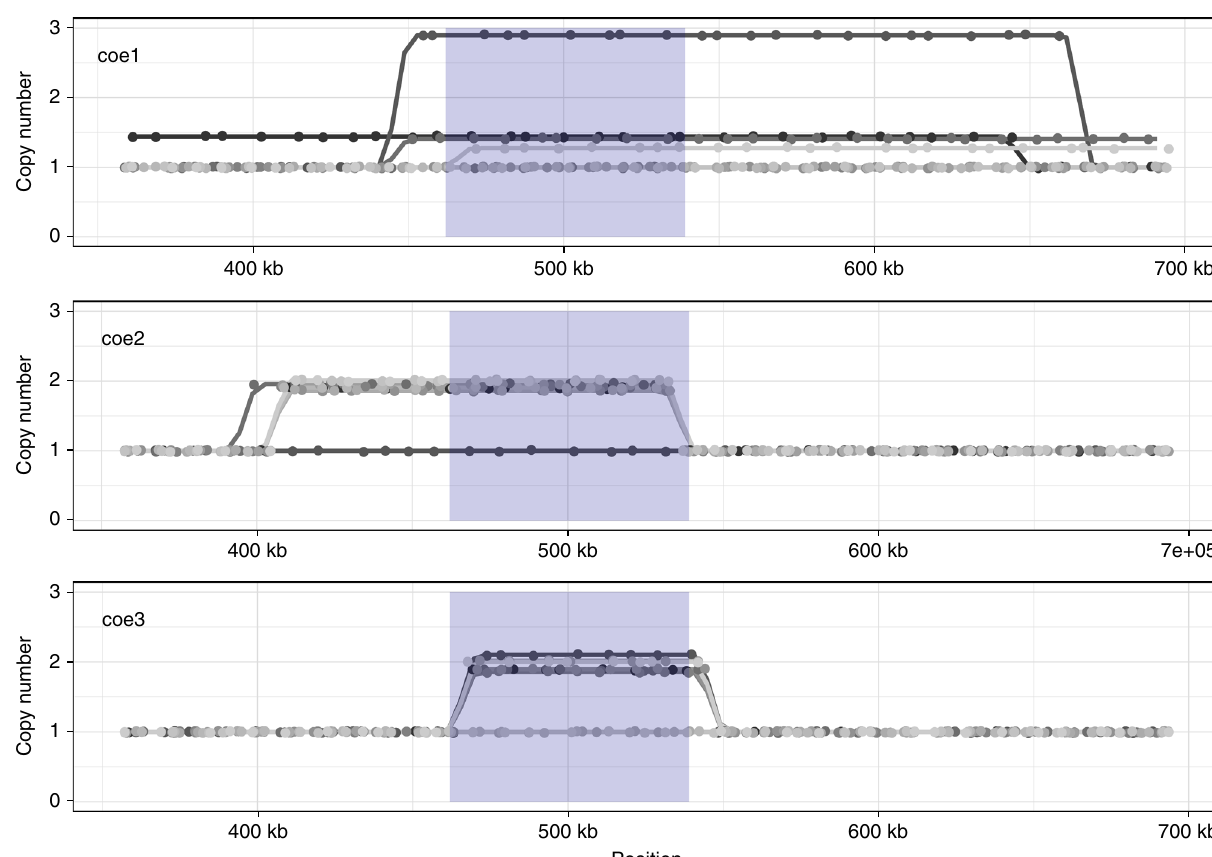
Fig. 6 Large duplication partially overlapping in all three coevolved populations. For each of the three replicates copy number estimates for each of the 10 clones are plotted across a section of scaffold 24. Copy number was approximated for 1 kb window size. For clarity, points are estimates for every window of size 1 kb and are plotted with a random offset not to overlap the other replicates. Copy number increases for every coevolved population (coe1 = 4 out of 10, coe2 = 8 out of 10, coe3 = 9 out of 10 clones). Blue shading highlights the region where all three populations show a signi fi cant increase in copy number. Abbreviations coe1 – coe3 correspond to the three coevolved